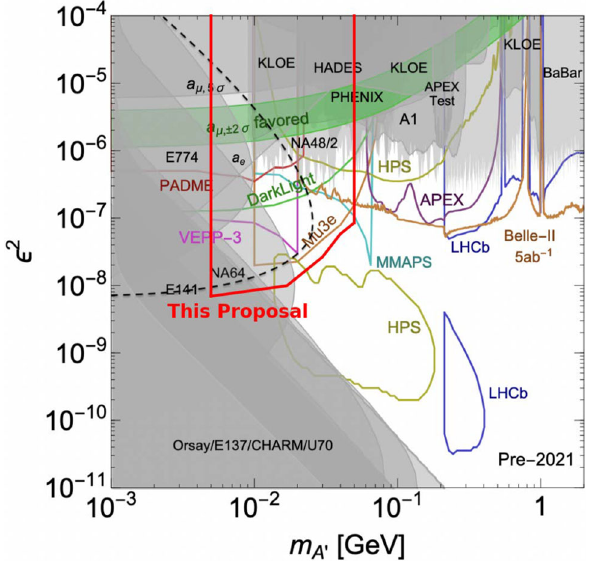
Fig. 51 Projected coverage of the square of the coupling constant ( (cid:7) 2 ) andmass( m X )parameterspacebythisproposedexperimentisshownas the thick red lines for the combined statistics of the two beam energies. The projections are superimposed on top of the constraints plot which was adapted from Ref. [214]